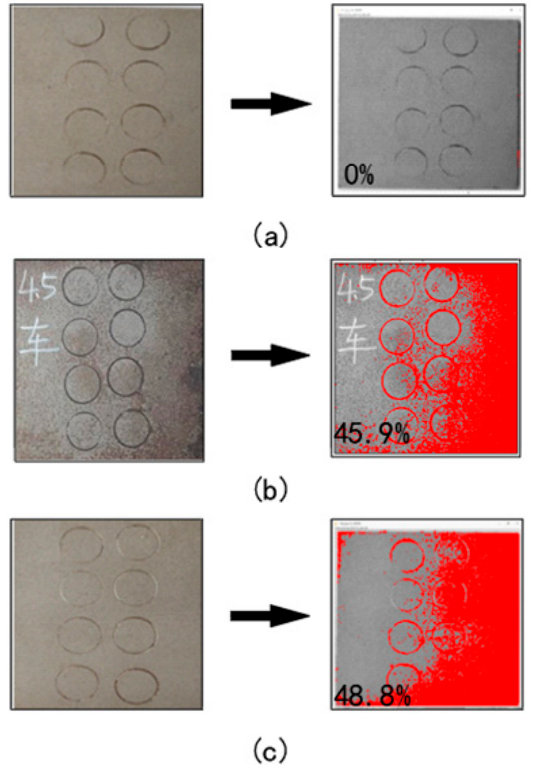
Figure 23. Corrosion of the with-zinc specimens after saltwater corrosion for ( a ) 0 days, ( b ) 14 days, and ( c ) 28 days (Note: the red area represents the corrosion area).